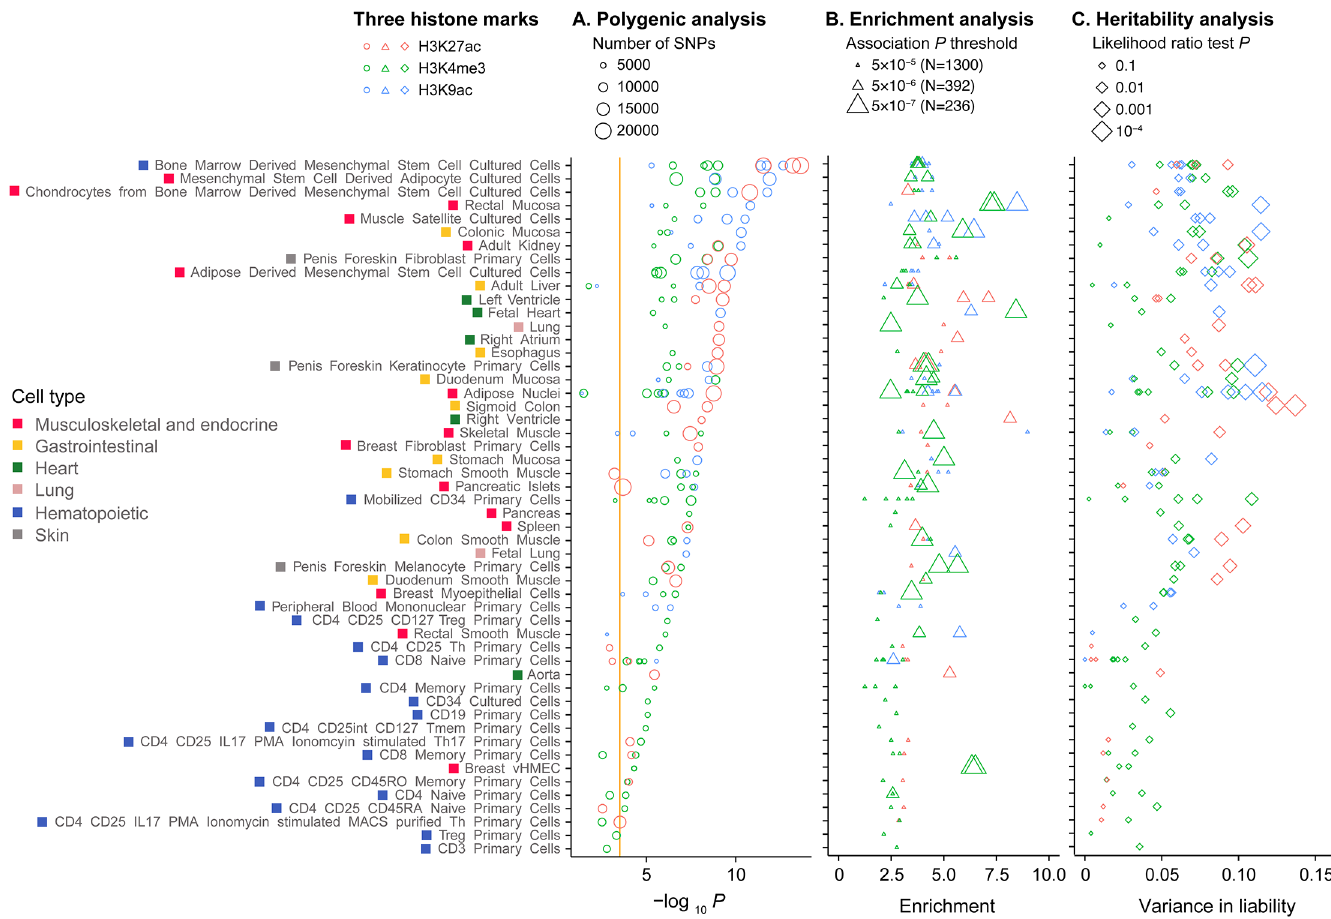
Fig 2. Polygenic, enrichment and heritability analysis of three histone modification marks across cell types. We performed three different analyses to test for cell type specific effects on the genetic risk for MI/CAD. Analyses were conducted on SNPs residing in the three histone marks (H3K27ac, H3K4me3, H3K9ac) that were present in the different cell types. (A) Polygenic risk score analysis. We performed polygenic risk score association analysis on SNPs with MIGen discovery association P < 0.05. Negative logarithm of P values from association testing of the polygenic risk score performed in the WTCCC CAD was shown. Cell types were sorted based on the strength of polygenic association. Orange vertical line represents a significant level with 5% alpha error. (B) Enrichment of association. Enrichment analyses were performed by comparing the proportion of significant variants passing a specific association P threshold of a variant set with that of a baseline set. Different association P thresholds 5×10 − 7 , 5×10 − 6 , 5×10 − 5 from the CARDIoGRAM study were tested [24]. The variant sets in this analysis were SNPs in the specified histone marks that were present in the indicated cell type. For the baseline set, we test SNPs in regions that are outside of these histone marks within 10 kilobases (kb) of the protein coding regions of the genome. To reduce the effects of linkage disequilibrium, these baseline SNPs were selected to be 5 kb away from the histone marks. In the plot, each triangular point represents the strongest enrichment result for each mark in each cell type across the three possible association P thresholds. (C) Heritability analysis. Heritability analysis was performed within histone marks in the MIGen study. Each point in the plot represents the variance in liability generated from a joint model involving two variance components using the Genome-wide Complex Trait Analysis software [22,23]. The two variance components include 1) SNPs in the specified histone mark that was present in the indicated cell type and 2) all other SNPs outside of these regions. The variance in liability is an estimate from the ratio of genetic variance to phenotypic variance for the specified variance component (i.e. the specified variance component is all SNPs within the specified histone mark) whereas the P value is from the likelihood ratio test of a reduce model with the specified genetic variance component dropped from the full model, from the restricted maximum likelihood method in the Genome-wide Complex Trait Analysis software [22,23]. MI, myocardial infarction; CAD, coronary artery disease; SNP, single nucleotide